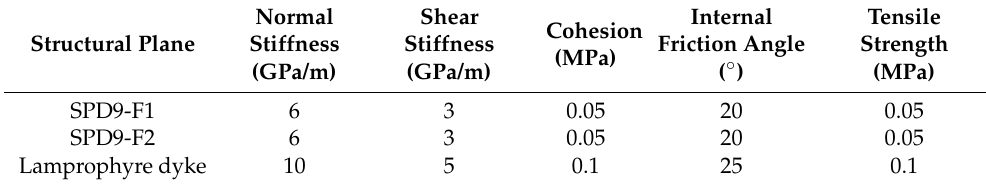
Table 4. Mechanical parameters of the structural planes.